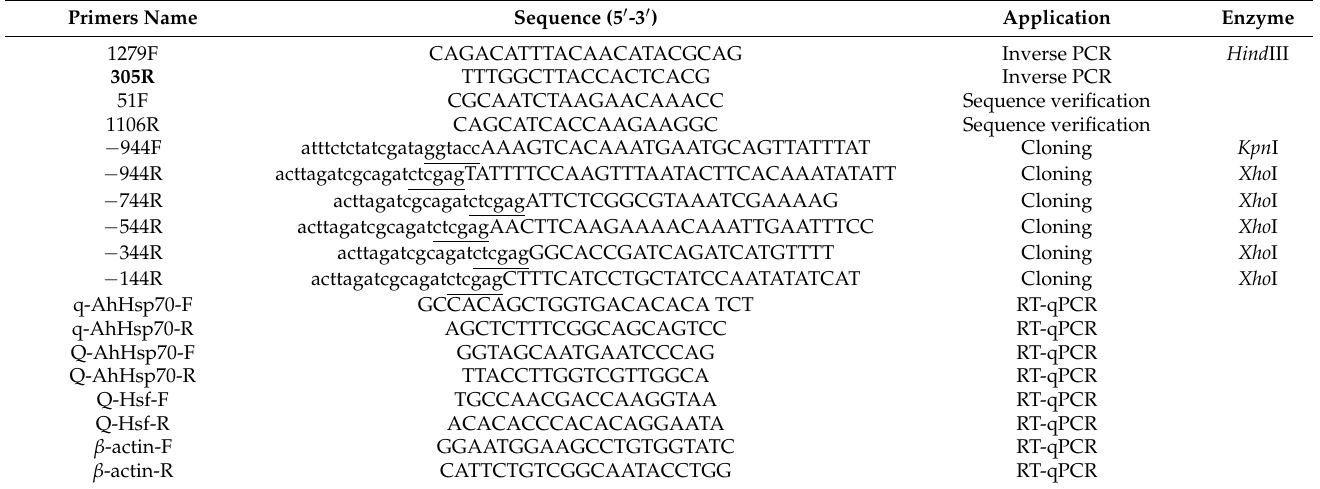
Table 1. Sequences of oligonucleotide primers used in this study, designed using CE V1.04 and primer 5.0 software. Note: the underline sequences are cleavage sites of restriction enzyme and the bases underlined with a wavy line are the homologous arm sequence of the upstream terminal of the